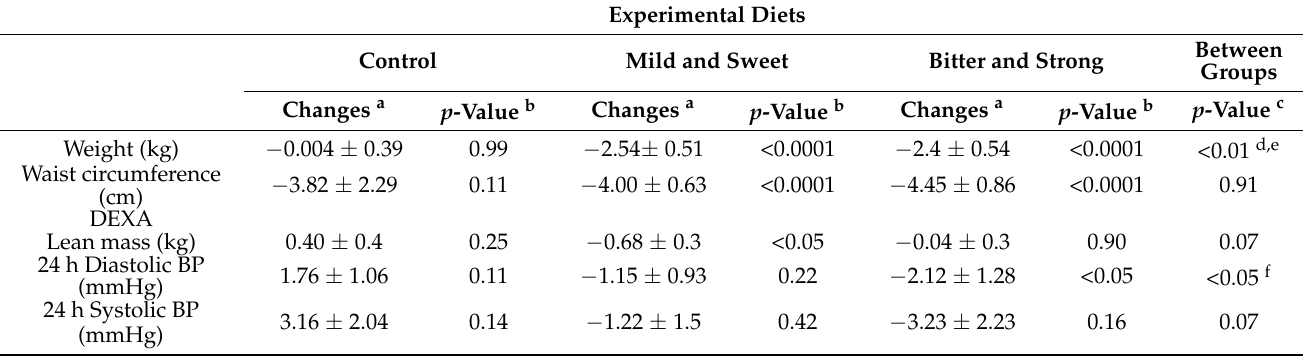
Table 4. Changes ( ∆ ) in weight, waist circumferences, lean mass, and blood pressure after a 12-week intervention.